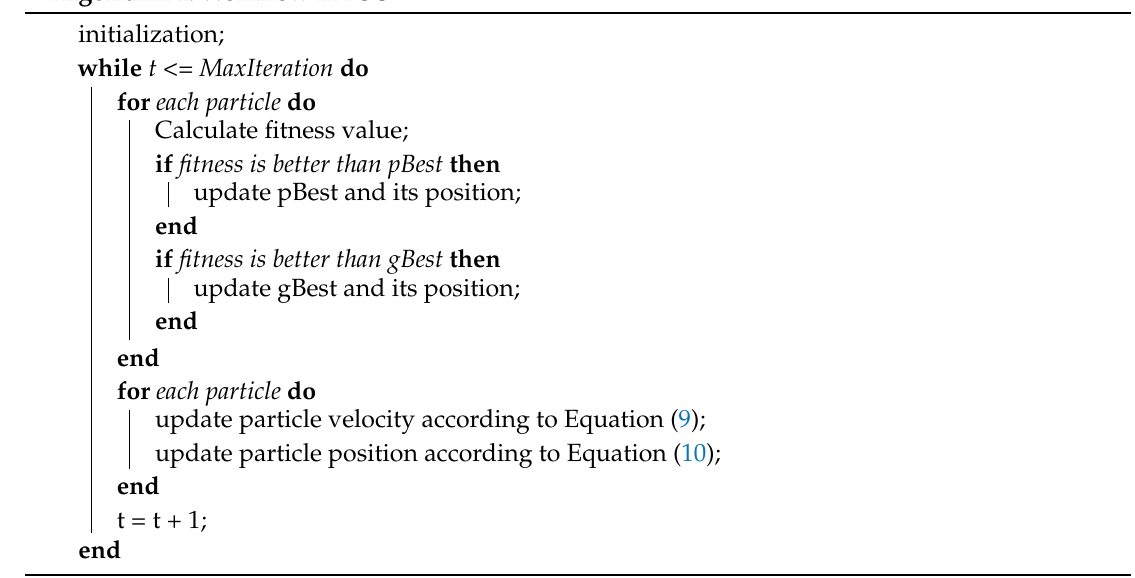
Algorithm 1: Workflow in